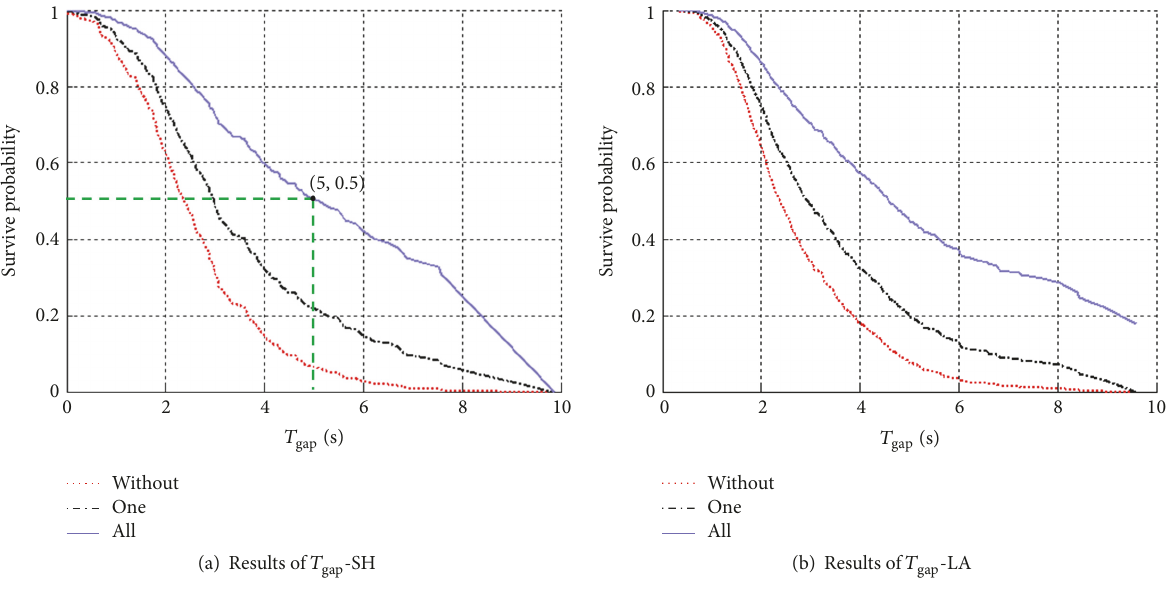
Figure 8: Results of